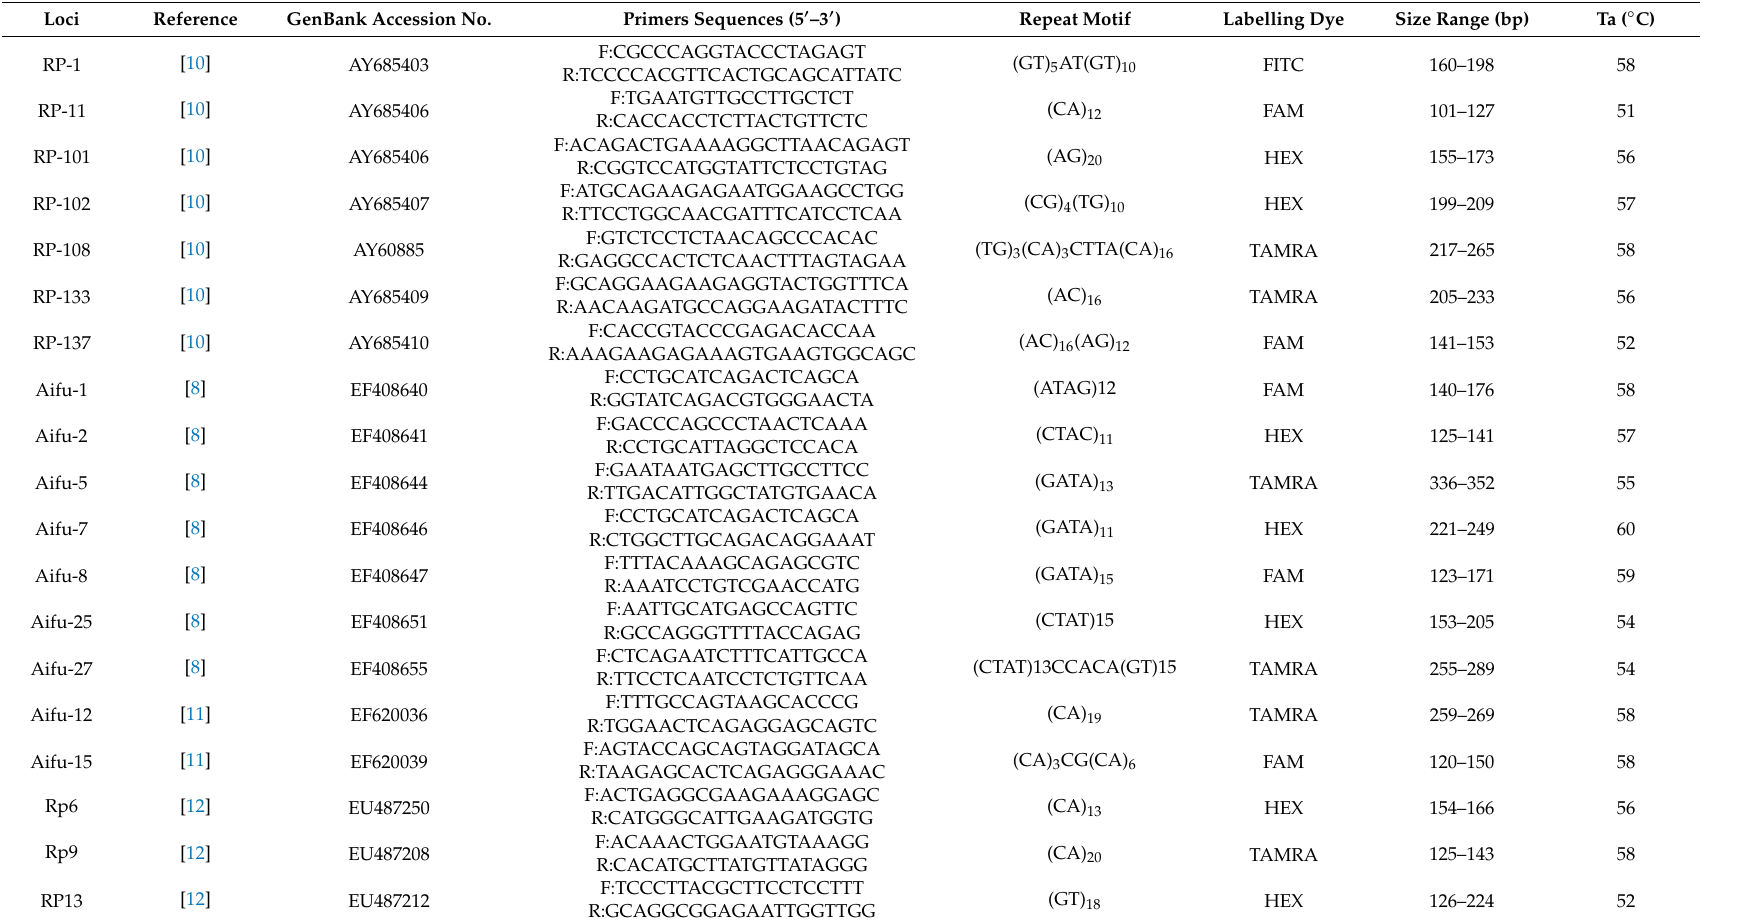
Table 1. 19 short tandem repeat (STR) markers used for analysis of genetic